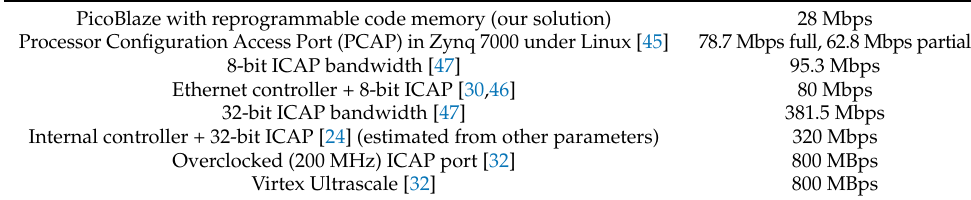
Table 1. Partial Reconfiguration Speed—Bitrate. PicoBlaze with reprogrammable code memory (our